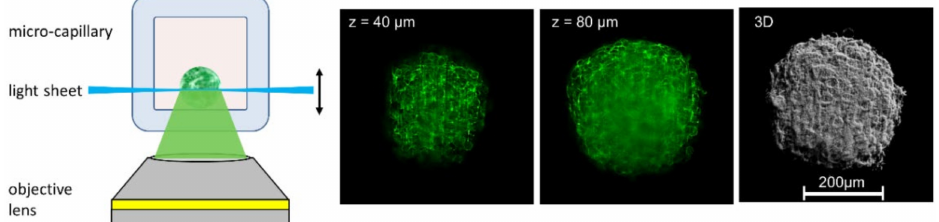
Figure 2. 3D imaging of CHO-pAcGFP1-Memcell spheroids with membrane-associated Green Fluorescent Protein (GFP). Light Sheet Fluorescence Microscopy (LSFM) using rectangular micro-capillaries (scheme, two single planes and 3D reconstruction); beam waist: ∆ z = 5–10 µ m, focal depth: ∆ y = 100–200 µ m (reproduced from Ref. [8] with